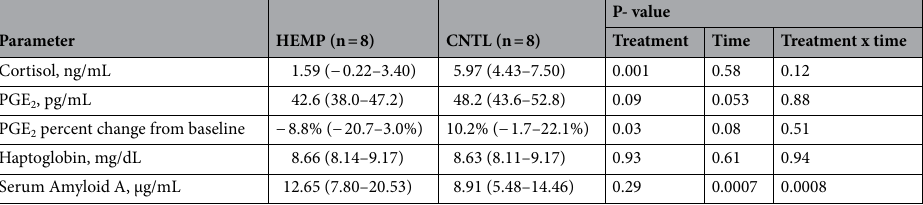
Table 4. Summary of mean (95% confidence interval) cortisol and prostaglandin E 2 (PGE 2 ) concentrations for cattle fed industrial hemp once a day for 14 days (HEMP) or control cattle